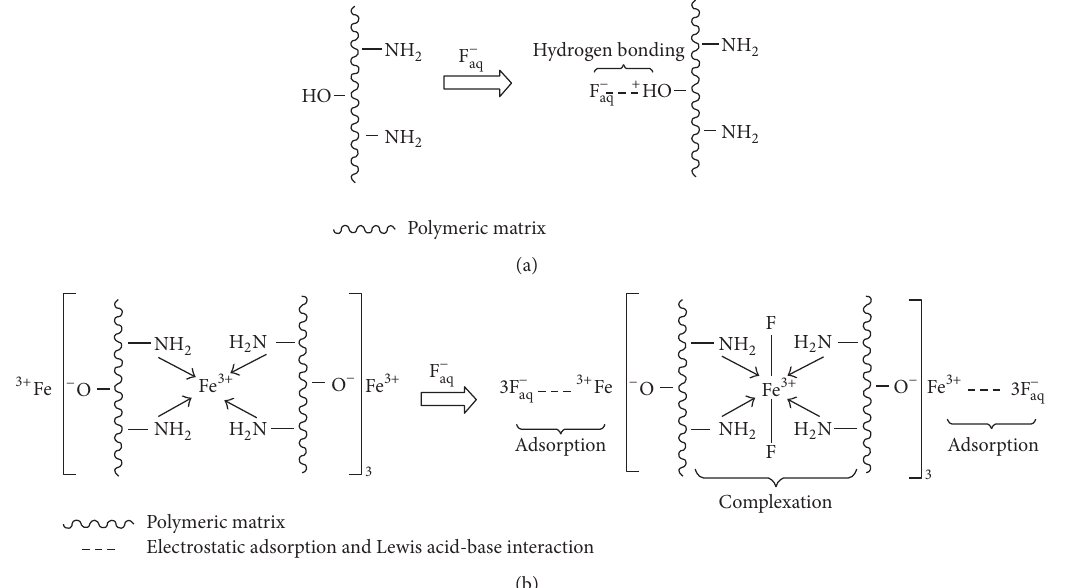
Figure 9: Fluoride removal mechanism (adapted from Viswanathan and Meenakshi [34]): (a) interaction with OH, (b) interaction with